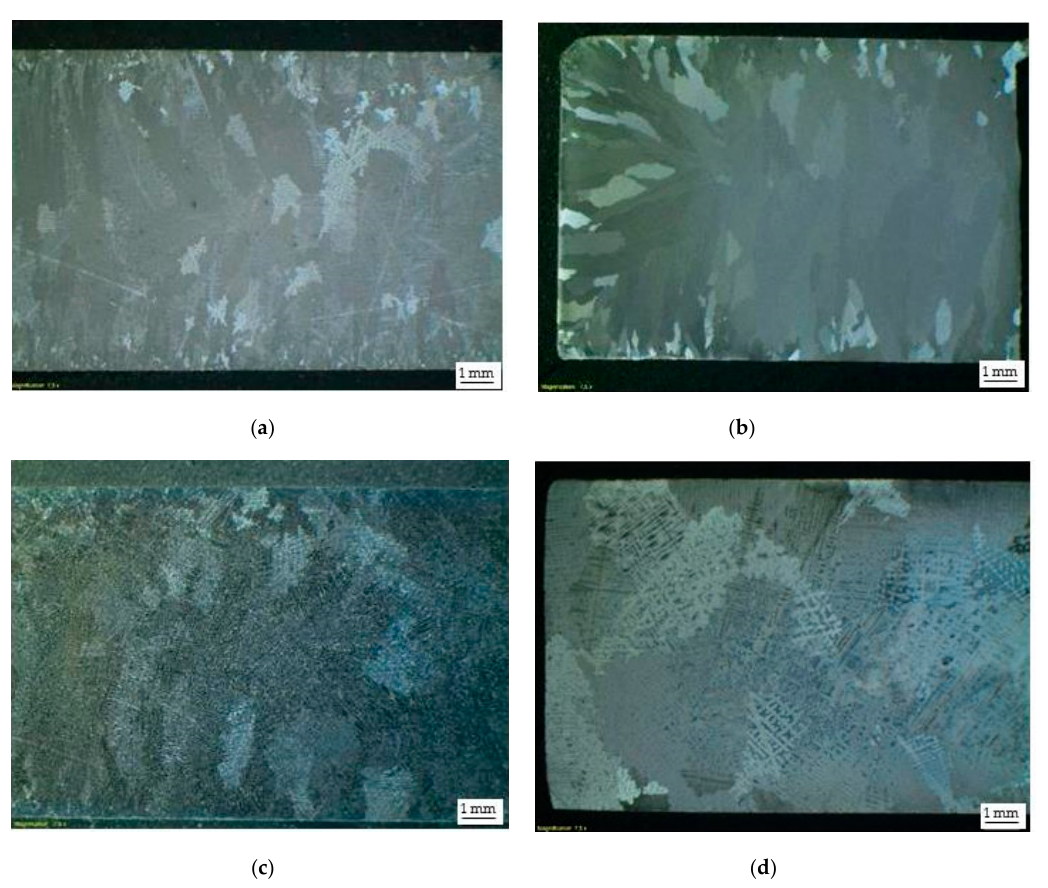
Figure 5. Grain size of different moulds in the as-cast state: ( a ) O, ( b ) E, ( c ) P, and ( d ) NP. Table 5. Segregation ratio (SR) of alloying elements after heat treatment.